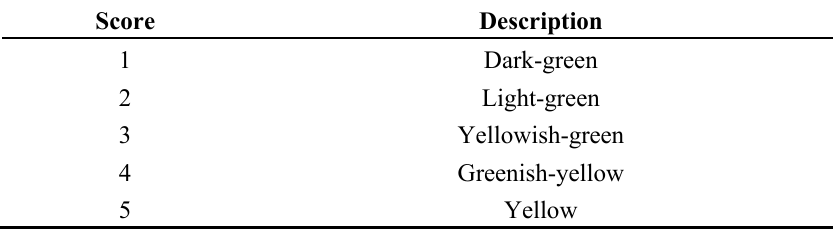
Table 2. Rating scale for the color of green vegetables.